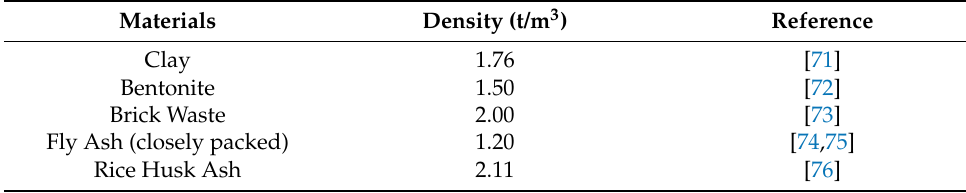
Figure 4. System Boundary Description—Cradle to Gate. Table 5. Density of materials used in the mineral layer comparative LCA